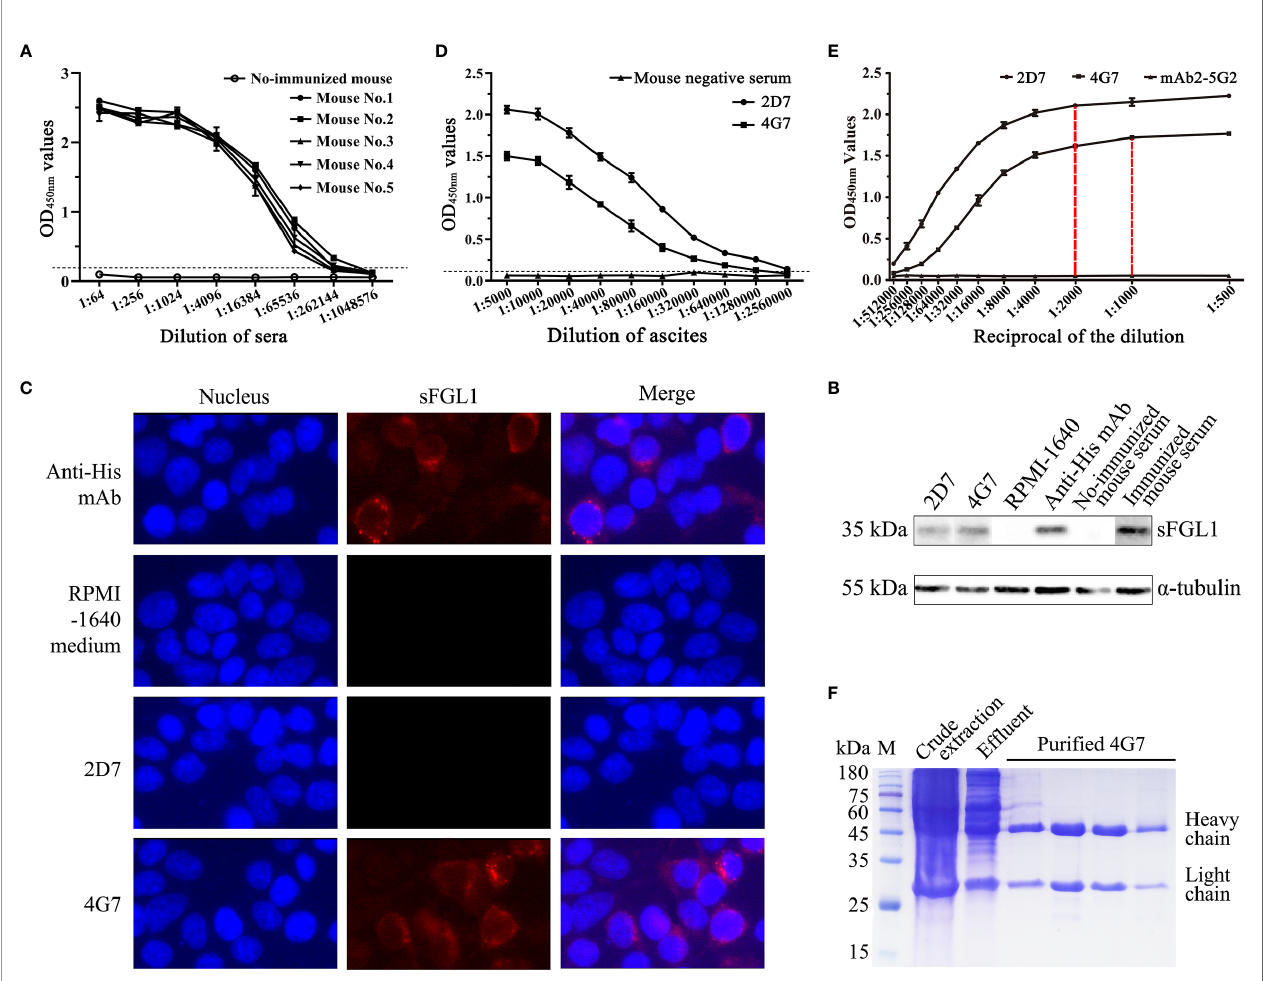
FIGURE 3 | Characteristics of mouse mAb against sFGL1. (A) Titers of antibody against sFGL1 in the sera of immunized mice. (B) Identify the reaction of 2D7 and 4G7 with sFGL1 expressed by HEK 293T cells with the Western blot method. (C) Identify the reaction of 2D7 and 4G7 with sFGL1 expressed by HEK 293T cells with IFA. (D) Titers of 2D7 and 4G7 in ascites. (E) The saturation curves of 2G7 and 4G7 with sFGL1. The plates were coated with 50 ng puri fi ed recombinant sFGL1 per well, different diluted 2D7 and 4G7 were used to perform an I-ELISA, mAb2-5G2 puri fi ed from ascites was used as a negative control. (F) Identify puri fi ed 4G7 by SDS-PAGE and Coomassie brilliant blue staining.